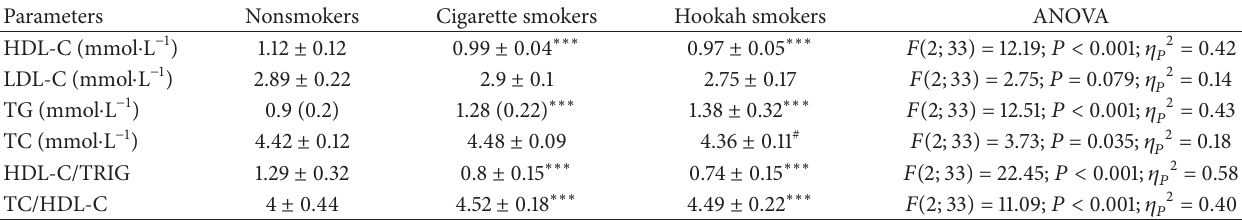
Table 4: Blood lipid levels of smokers and nonsmokers before training program (mean ± SD).